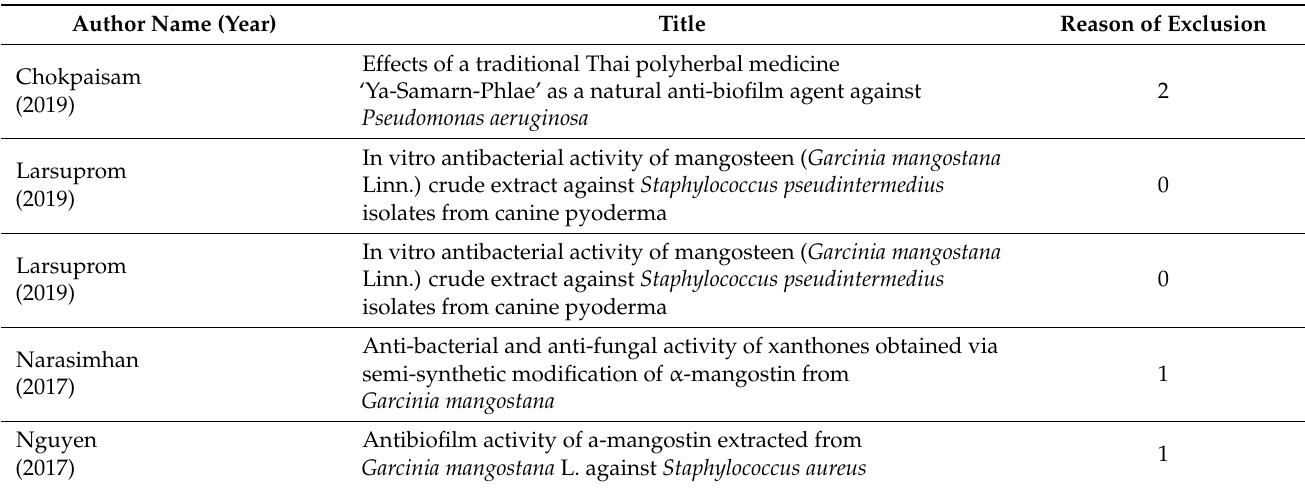
Table 3. Articles excluded from this meta-analysis with their reasons for